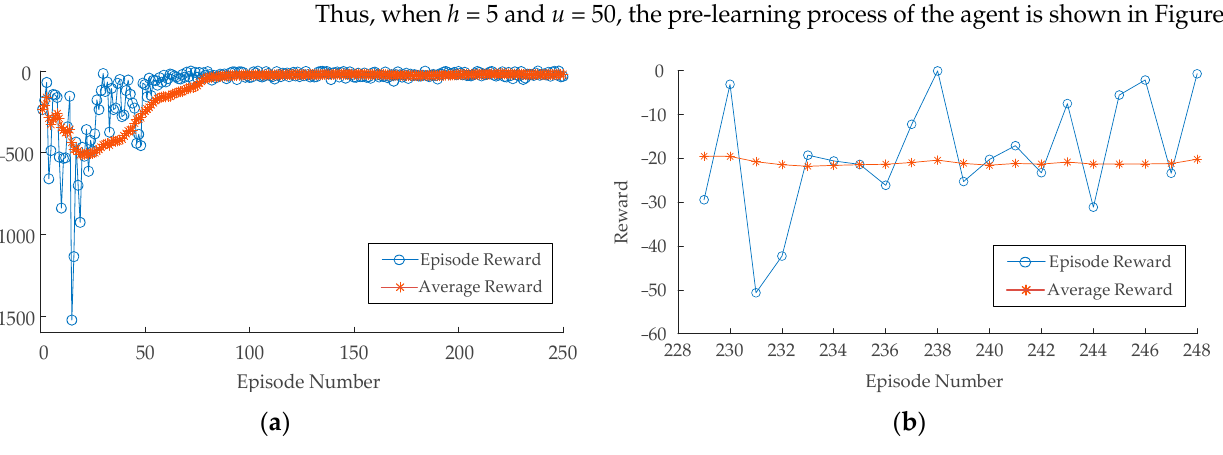
Figure 9. The complete trend graph of the reward function: ( a ) The complete trend graph of the reward function; ( b ) the trend graph of the reward function for the last 50 iterations.